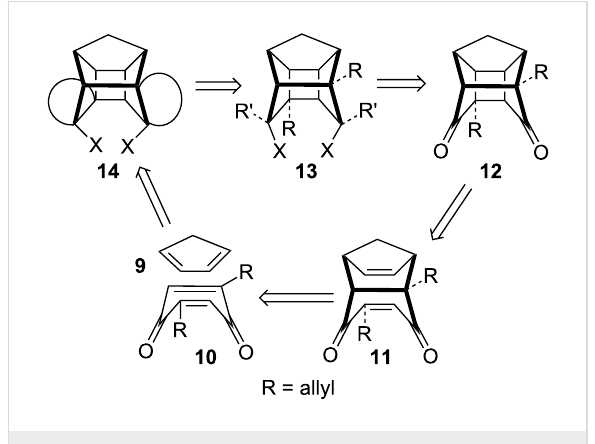
Figure 2: Retrosynthetic approach toward bis-annulated